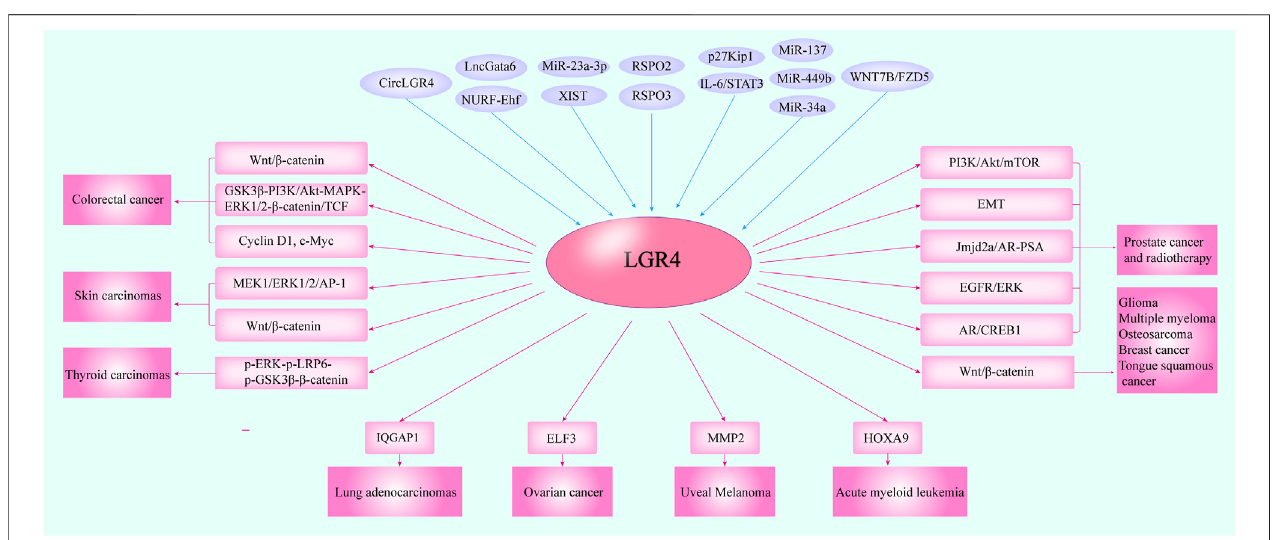
FIGURE4| Thecross-talkingofLGR4withothermoleculesinmultiplecarcinomas.SeveralstudiesindicatedthatLGR4wasoverexpressedincancertissues.The molecules including circLGR4, lncGata6-NURF-Ehf, XIST/miR-23a-3p, miR-137, miR-449b, miR-34a, IL-6/STAT3, p27Kip1, WNT7B/FZD5, and RSPO2/3 could function as upstream regulators of LGR4 and mediate its expression. Then, LGR4 could modulate the proteins such as IQGAP1, ELF3, MMP2, and HOXA9 to control tumor progression and trigger the Wnt/ β -catenin, MEK1/ERK1/2/AP-1, PI3K/Akt pathways to promote the initiation and metastasis of a variety of malignancies.